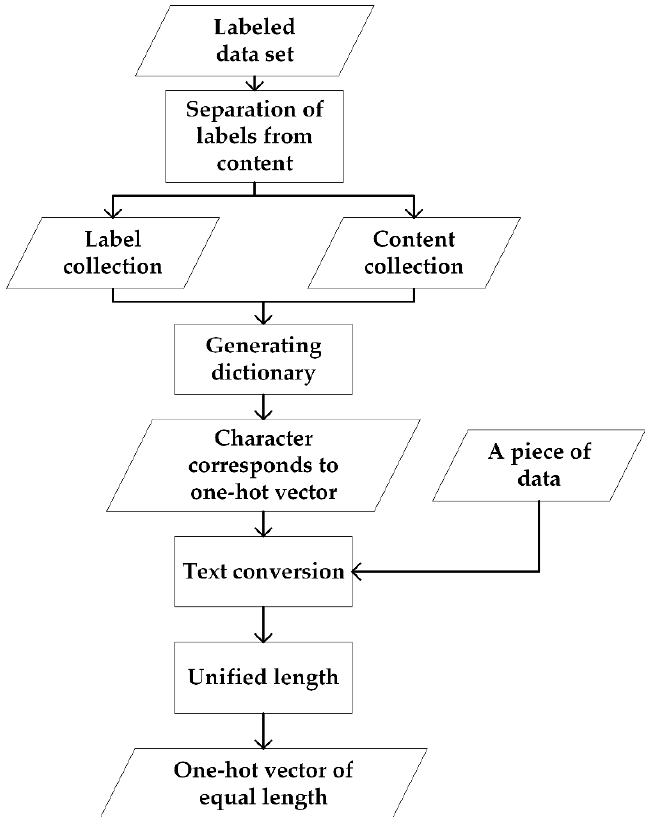
Figure 5. Generation of the one-hot vector.